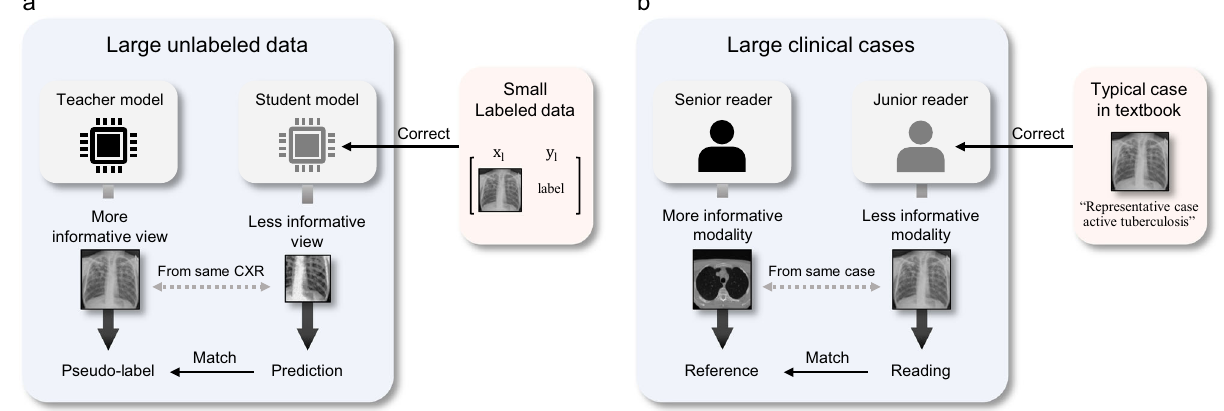
Fig. 9 The analogy between the arti fi cial intelligence (AI) model training with the proposed DISTL method and human reader training. a The learning process of AI model trained with the proposed DISTL method. b The learning process of a radiologist. CXR,